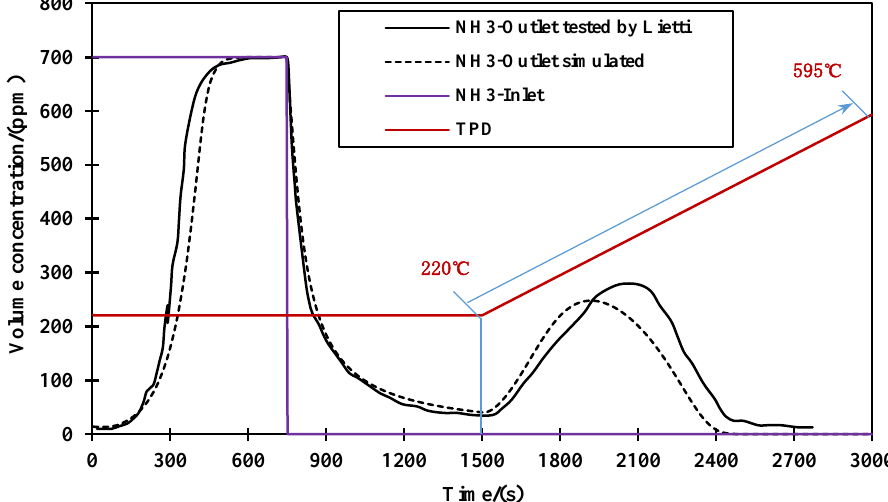
Figure 18. Simulation verification of the NH 3 adsorption and desorption reaction.